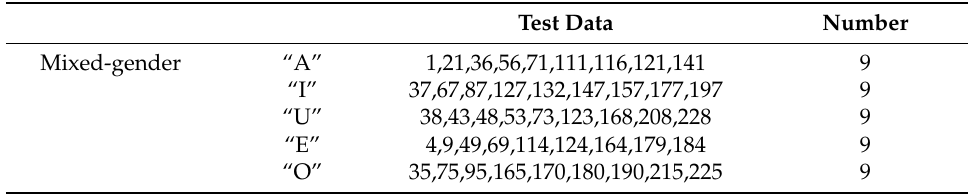
Table 5. Record no. combinations of test data used in each experiment (training and verification data used for k-fold cross-validation used records other than those in this